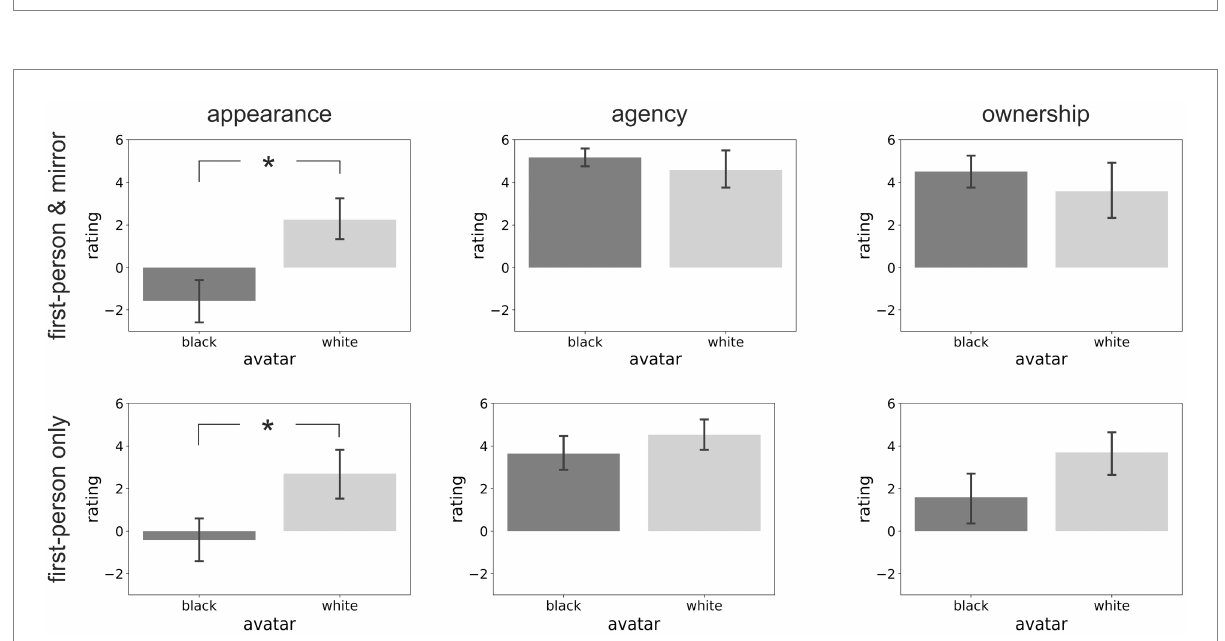
FIGURE 3 Results of the appearance, agency and ownership questionnaires – The six panels show the appearance (left column), agency (middle column) and ownership (right column) ratings obtained in the post-experiment questionnaires when participants could see their body in both the first- person perspective and in a mirror (“first-person and mirror” condition, upper row) and when they could see it only from a first-person perspective (“firstperson only” condition, lower row). Vertical bars represent standard error. Significant differences are highlighted by an asterisk